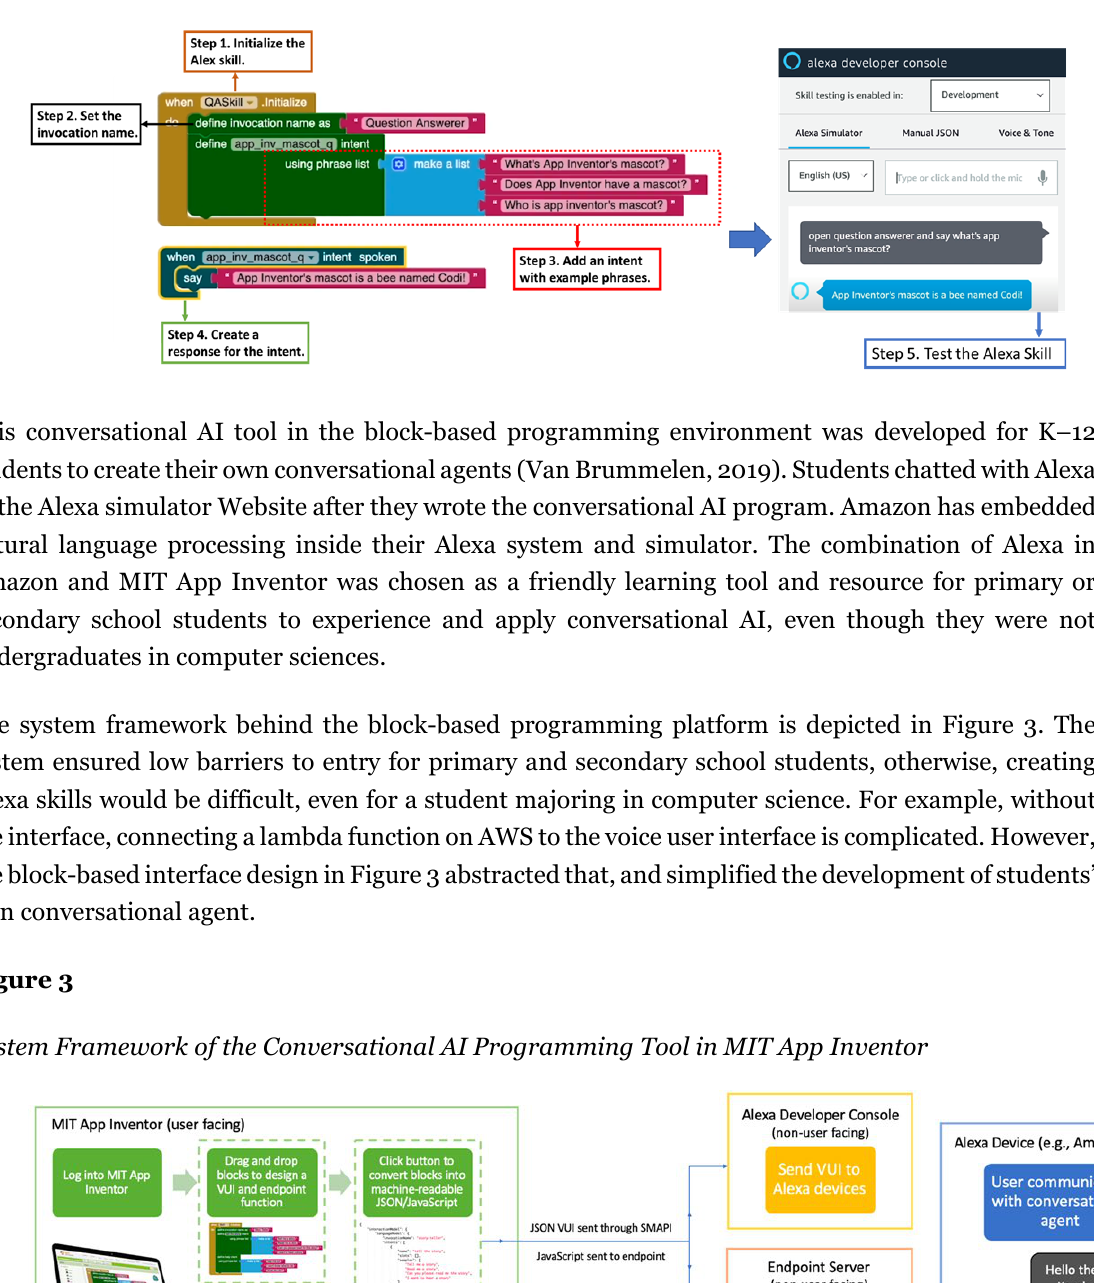
Example Program in the Block-Based Programming Conversational AI